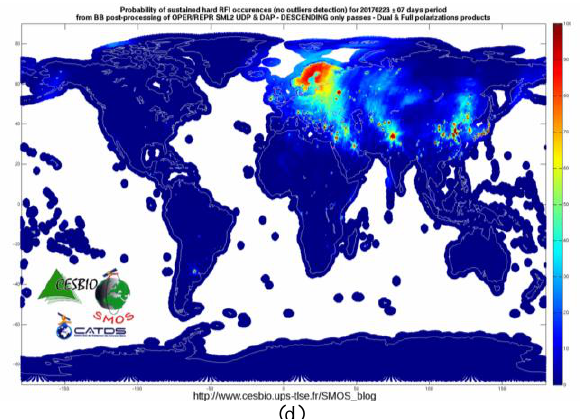
Figure 2. Probability of RFI occurrences from 17 th November